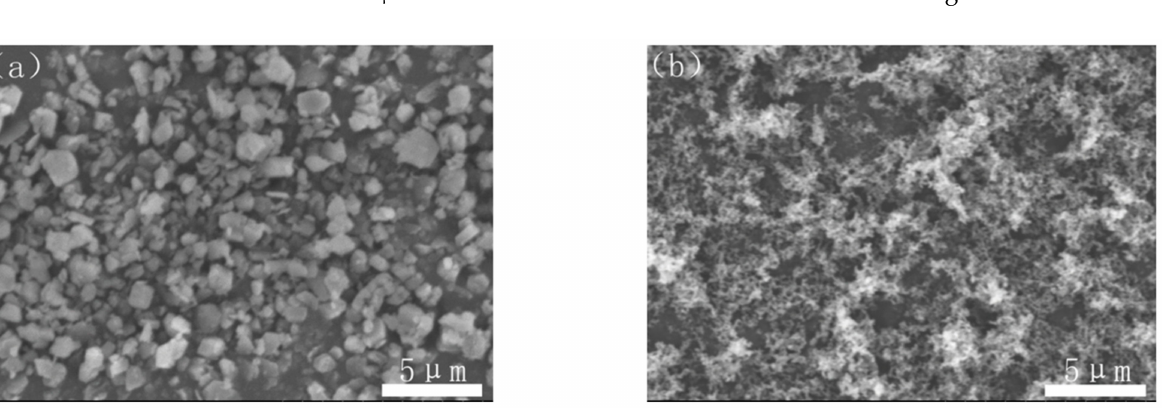
Figure 1. SEM images of ( a ) Al(OH) 3 and ( b ) carbon